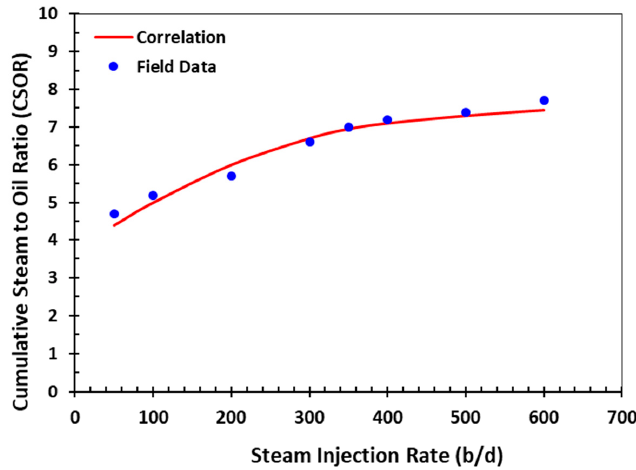
Figure 1. CSOR vs. oil viscosity for the database analyzed.